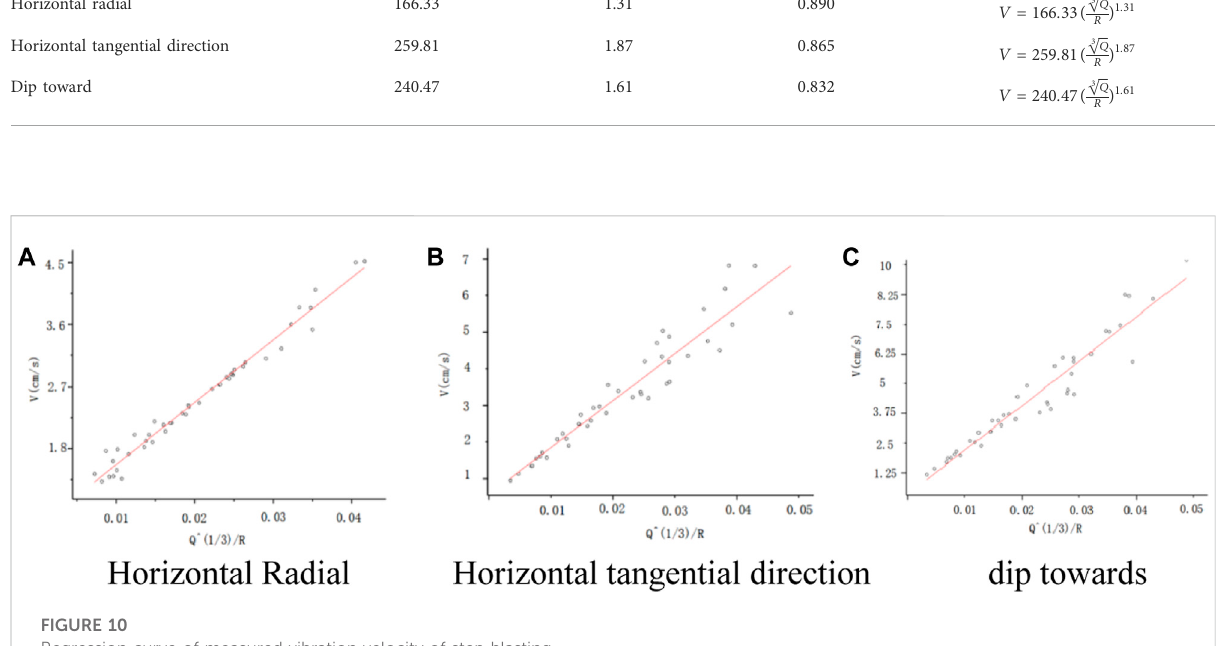
Figure 10. The correlation coef fi cient R is a close degree of